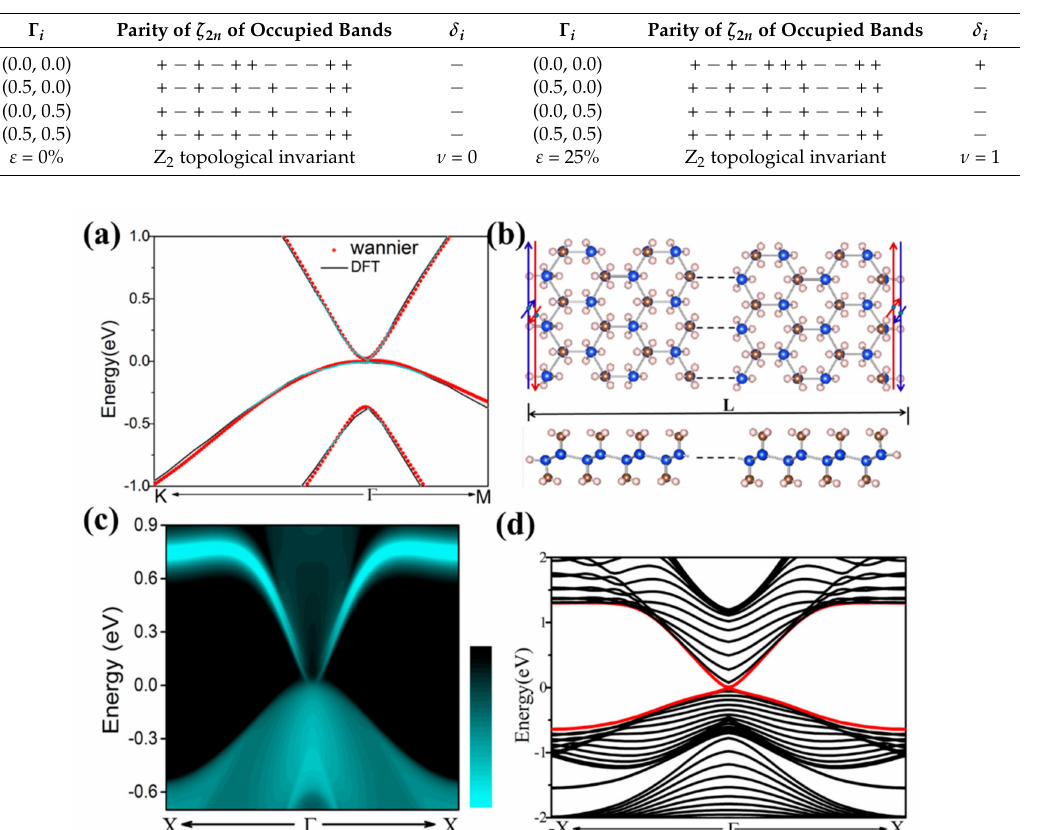
Table 1. Parities of occupied spin-degenerate bands at the time reversal invariant momentum (TRIM) Points for silicene (SiCH 3 ). Here, we show the parities of 11 occupied spin-degenerate bands for SiCH 3 ( ε = 0% and ε = 25%). Positive and negative signs denote even and odd parities, respectively.